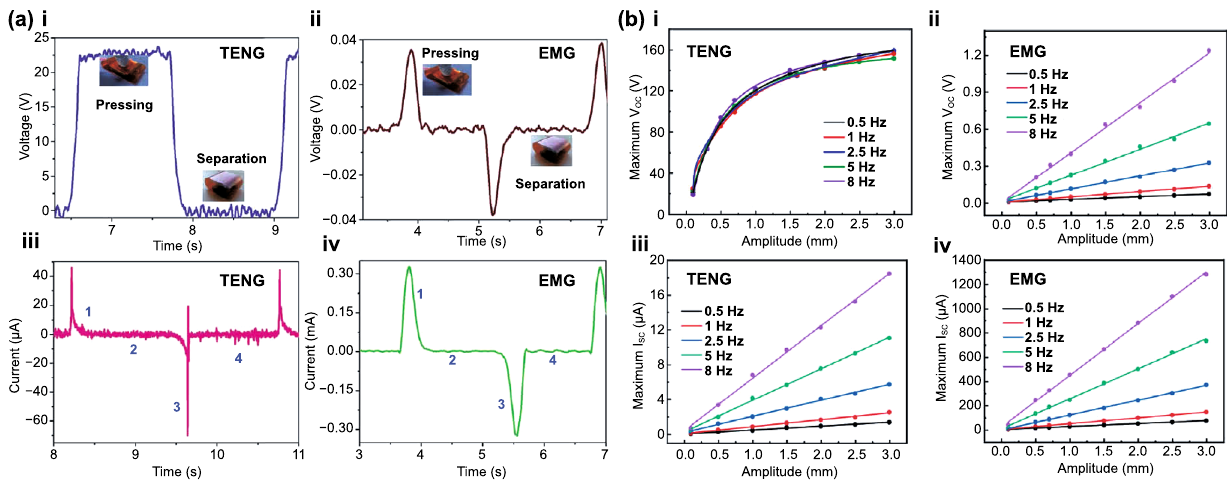
Fig. 4 a Typical time response of an hybrid generator with a coupled linear EMG and contact-separation TENG to a square-wave mechanical finger tap input: (i) OC voltage of the TENG; (ii) OC voltage of the EMG; (iii) SC current of the TENG; (iv) SC current of the EMG. The volt- age of the TENG is ca. proportional to the displacement, while the current of the TENG, voltage and current of the EMG are ca. proportional to the velocity. Reproduced with permission from Ref. [93]. Copyright 2017, Creative Commons Attribution 3.0 Unported Licence. b Typical vari- ation of the output OC voltage amplitude and SC current amplitude of an EMG and TENG with the amplitude of displacement and frequency of an excitation sinusoidal input. (i) OC voltage of the TENG; (ii) OC voltage of the EMG; (iii) SC current of the TENG; (iv) SC current of the EMG. The voltage from the EMG increases linearly with the amplitude, while the voltage from the TENG increases linearly up to a saturation value. The current from both generators increases linearly with the amplitude. The voltage from the EMG increases linearly with the frequency; differently, the voltage from the TENG follows an increasing trend up to a stationary value. The current from both generators increases linearly with the frequency. Reproduced with permission from Ref. [61]. Copyright 2019, Nano Energy. (Color figure